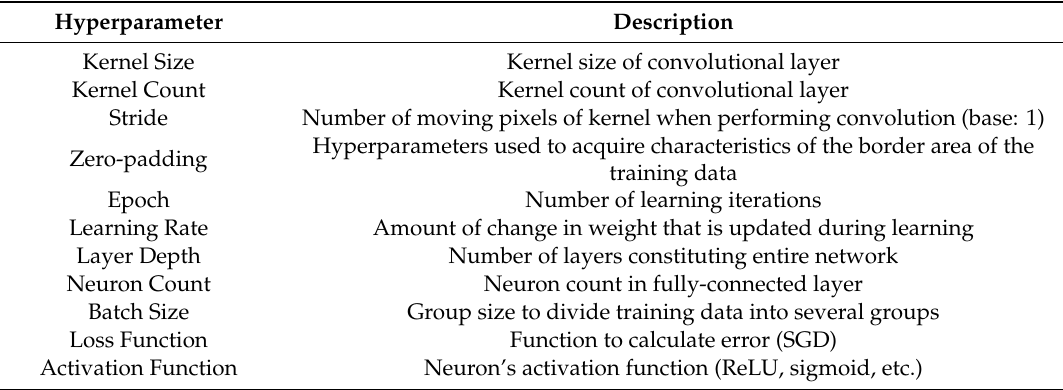
Table 3. Hyperparameters of general 1D